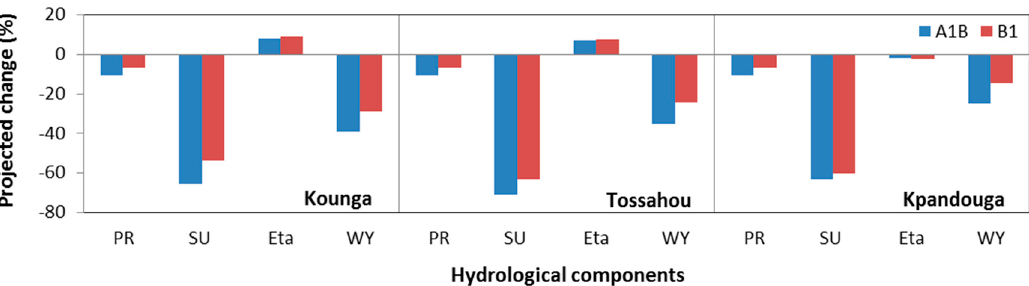
Figure 5. Changes in the annual water balance components under climate change scenarios during the projected period of 2030–2049. A1B and B1 are climate change scenarios; ETa is actual evapotranspiration; PR is precipitation; SU is surface runoff; and WY is total water yield.